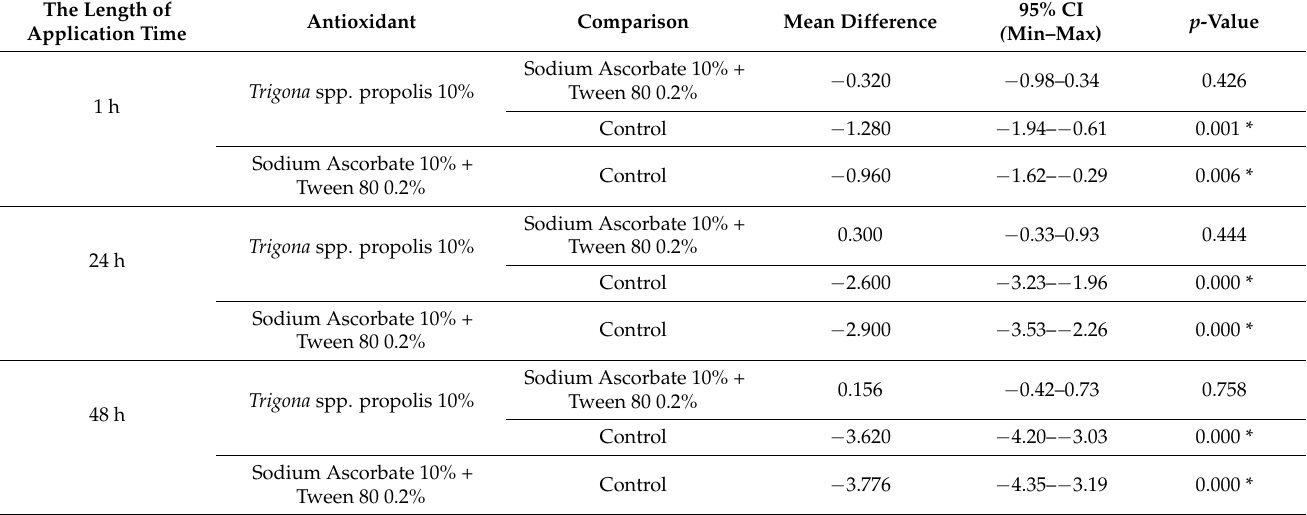
Figure 2. The average distribution of dissolved oxygen in the antioxidant and control groups with different lengths of application, i.e., 1 h, 24 h, and 48 h. (* Difference between average of dissolved oxygen in each antioxidant group for 1 h, 24 h, and 48 h was statistically significant at 0.05 level). To see further group differences, a post hoc test was conducted. Table 2 shows the results of the advanced difference test between the Trigona spp. propolis 10% group, sodium ascorbate 10% combined with Tween 80 0.2% group, and control group with different application times of 1 h, 24 h, and 48 h. There was a significant difference between Trigona spp. propolis 10% and the control group. The same result was also found between the sodium ascorbate 10% combined with Tween 80 0.2% group and the control group. However, no significant difference was found between Trigona spp. propolis 10% and sodium ascorbate 10% combined with Tween 80 0.2%. Table 2. The difference test results showing comparisons among antioxidant groups, i.e., Trigona spp. propolis 10%, sodium ascorbate 10% combined with Tween 80 0.2%, and control group, with different lengths of application, i.e., 1 h, 24 h, and 48